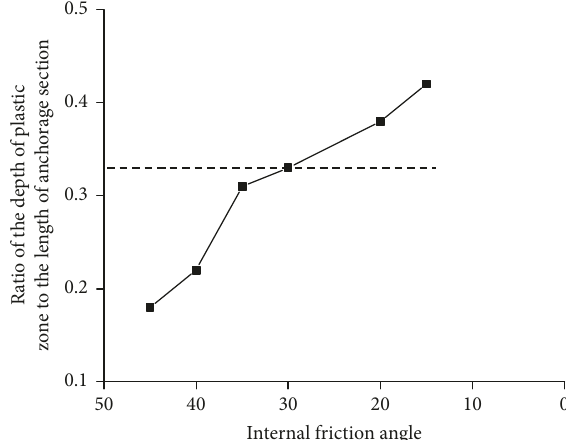
Figure 18: Relationship between the plastic zone development depth and internal friction angle.